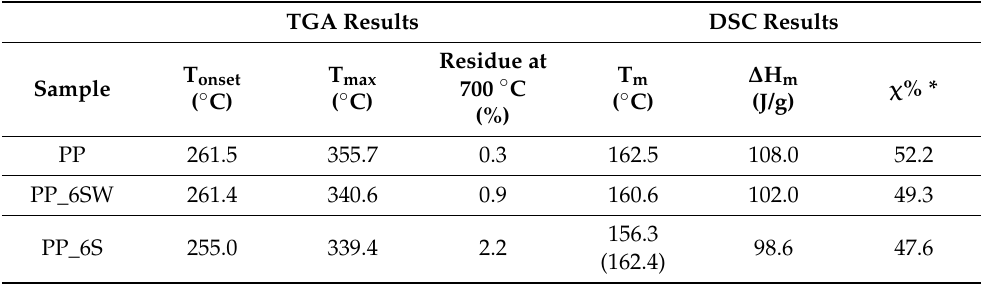
Figure 7. DSC thermograms of the series ( a ) HDPE, ( b ) PP, ( c ) PLA and ( d ) PBAT: raw granules in black; 6 ‐ months ‐ aged in seawater in blue; 6 ‐ months ‐ aged in sandbox in orange. Table 6. TGA and DSC results of PP